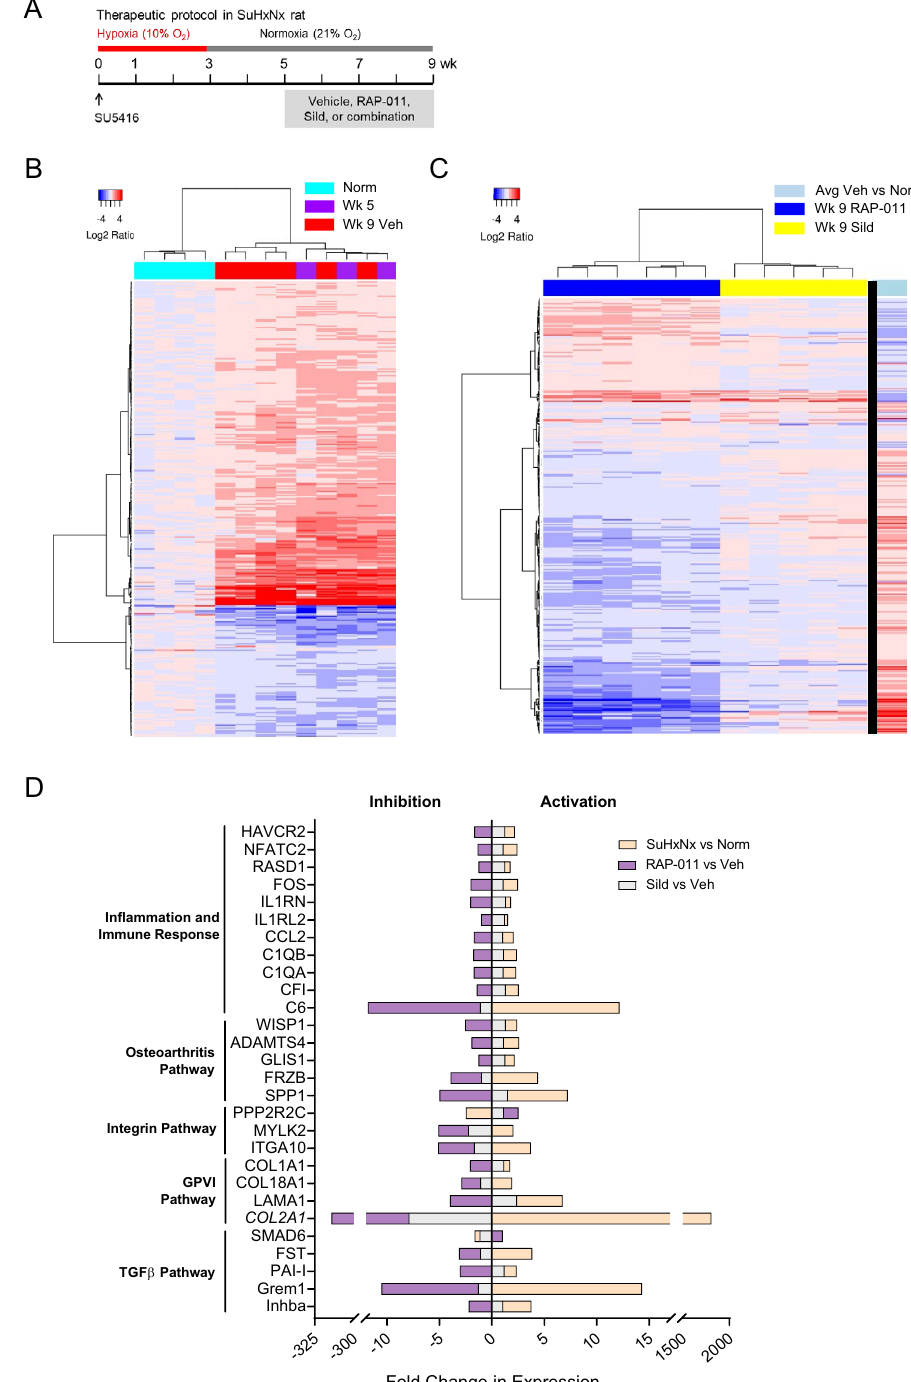
Figure 1. Therapeutic treatment with ActRIIA-Fc broadly normalizes pulmonary gene expression in severe experimental PAH. ( A ) Experimental approach used to evaluate therapeutic effects of RAP-011 in a Sugen-hypoxia-normoxia (SuHxNx) rat model of severe PAH. Rats were treated on day 0 with a single dose of SU5416 (20 mg/kg) and exposed to normobaric hypoxia (10%